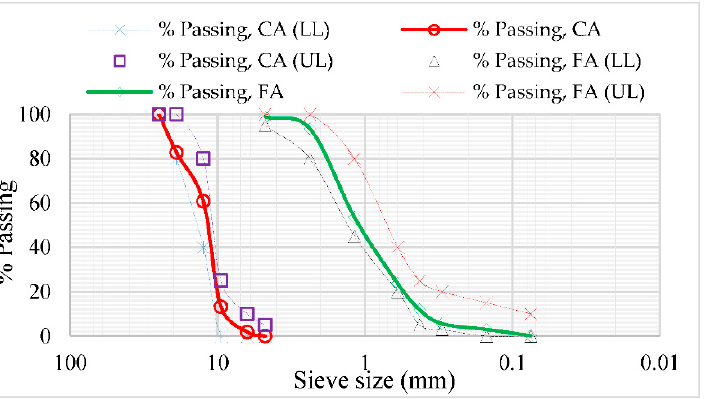
Figure 1. The PSD of binding materials used.